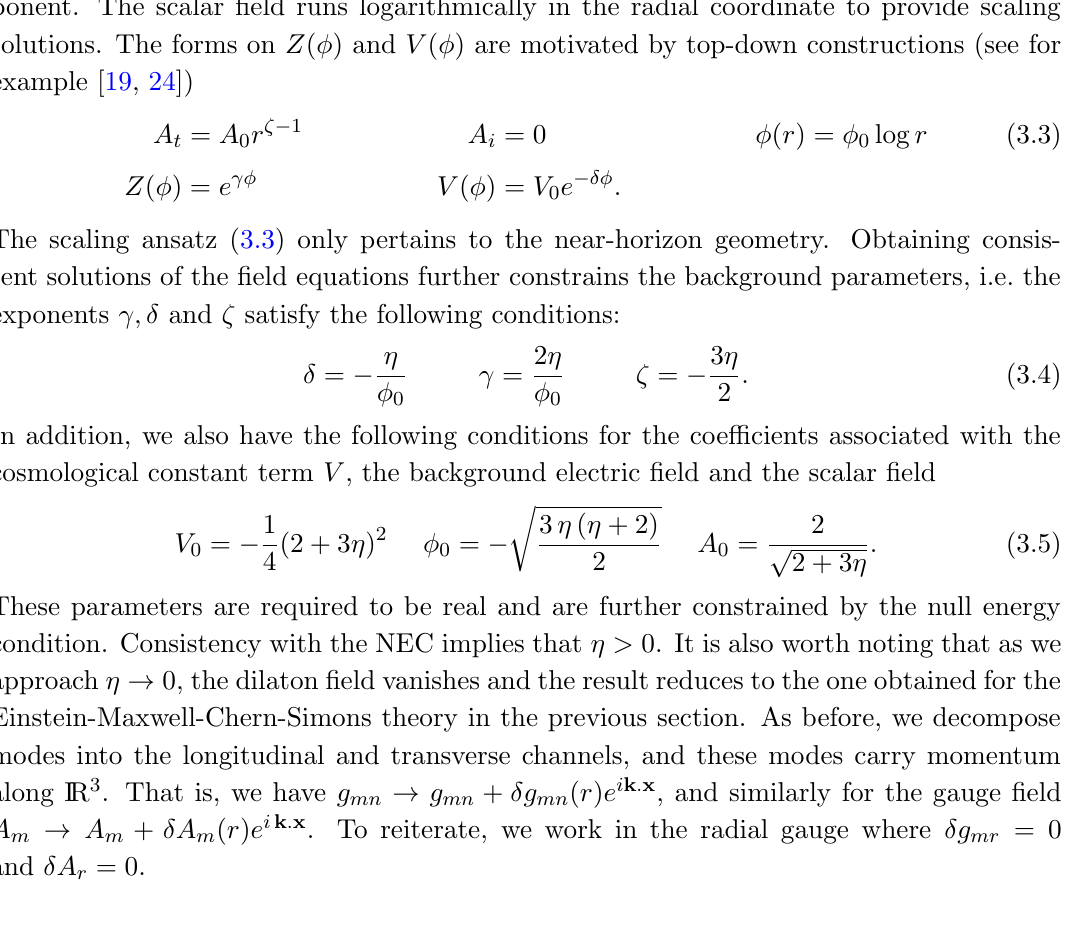
exponent z ! 1 while keeping a ratio of z and the hyperscaling violating exponent